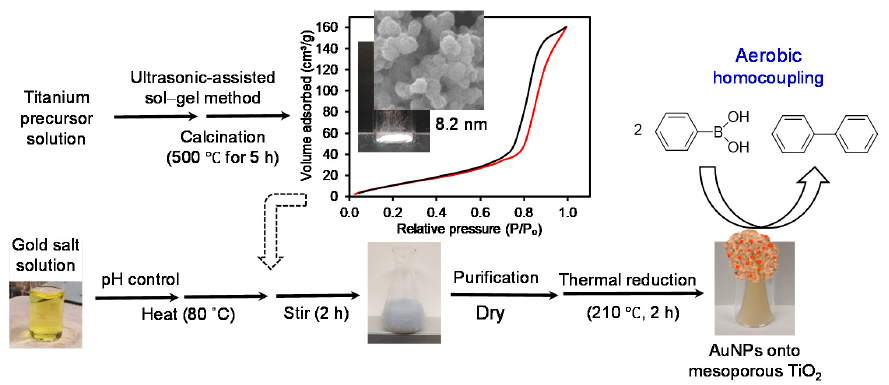
Figure 1. The preparation of mesoporous TiO 2 (MPT) particles (SEM image and BET graph) and physically incorporated AuNPs on MPT particles via deposition precipitation.